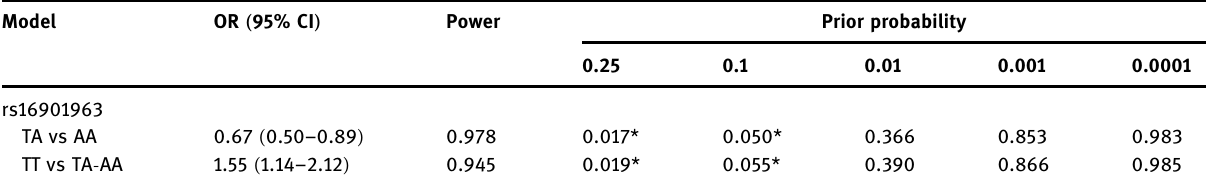
Table 4: Results of FPRP analysis for signi fi cant fi ndings